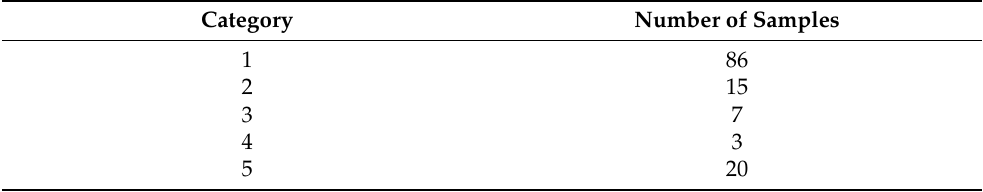
Table 2. Distribution and number of the data samples that were used in this